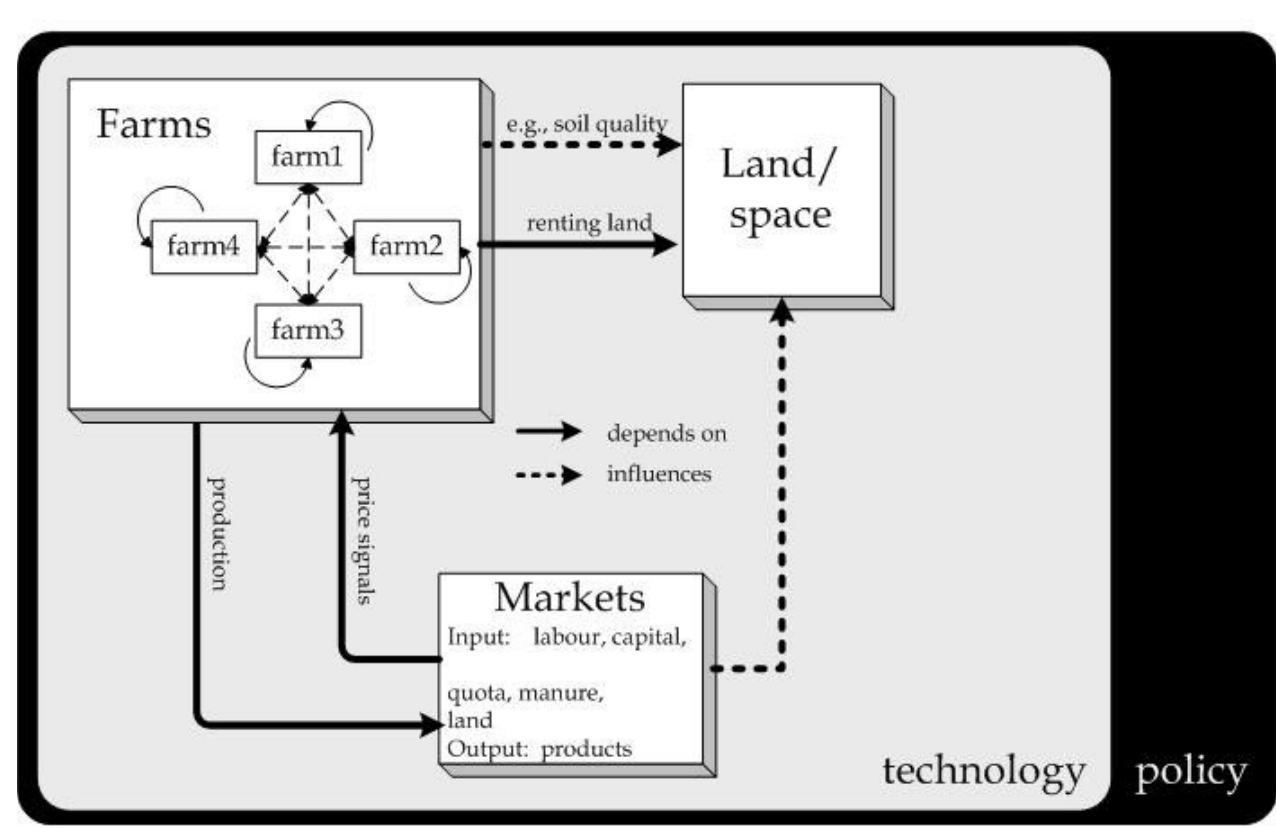
Fig. 1. Conceptual framework of